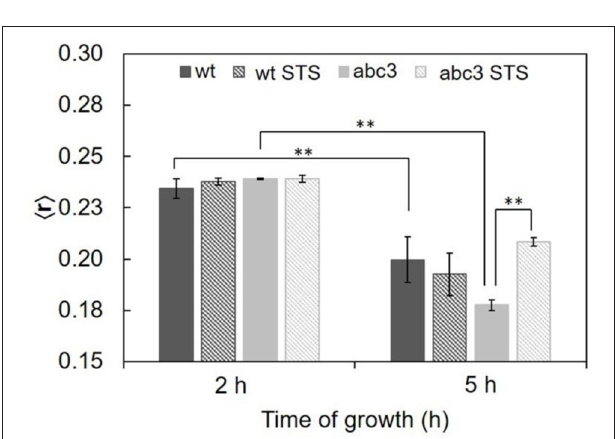
FIGURE 4 | Steady-state fluorescence anisotropy of DPH in the plasma membrane of N. crassa conidia, at 30 ◦ C of the wild type (wt) or abc3 mutant, after 1h incubation in the absence or presence of 12.5 µ M STS. The values are the mean ± S.D. of at least three independent experiments, n ≥ 3. ** p <